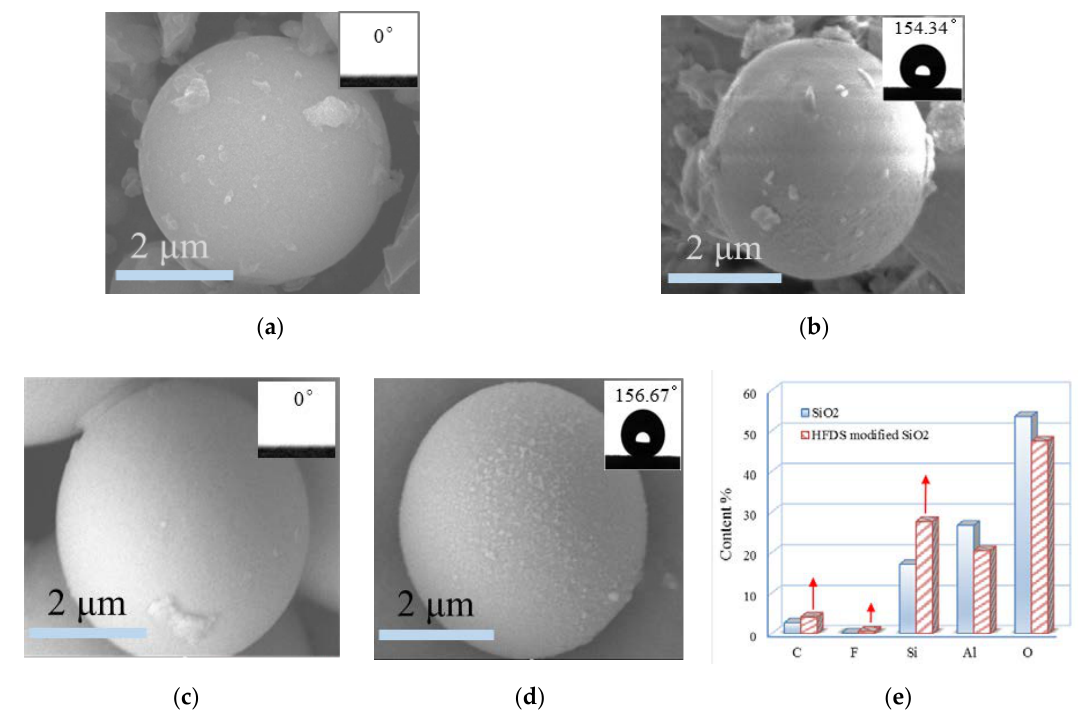
Figure 8. SEM–EDS comparison of particles (1 mL HFDS, 5 g UFA, and 50 mL ethanol). ( a ) UFA particle; ( b ) HFDS-modified UFA particle; ( c ) SiO 2 particle; ( d ) HFDS-modified SiO 2 ; ( e ) Comparison of EDS.